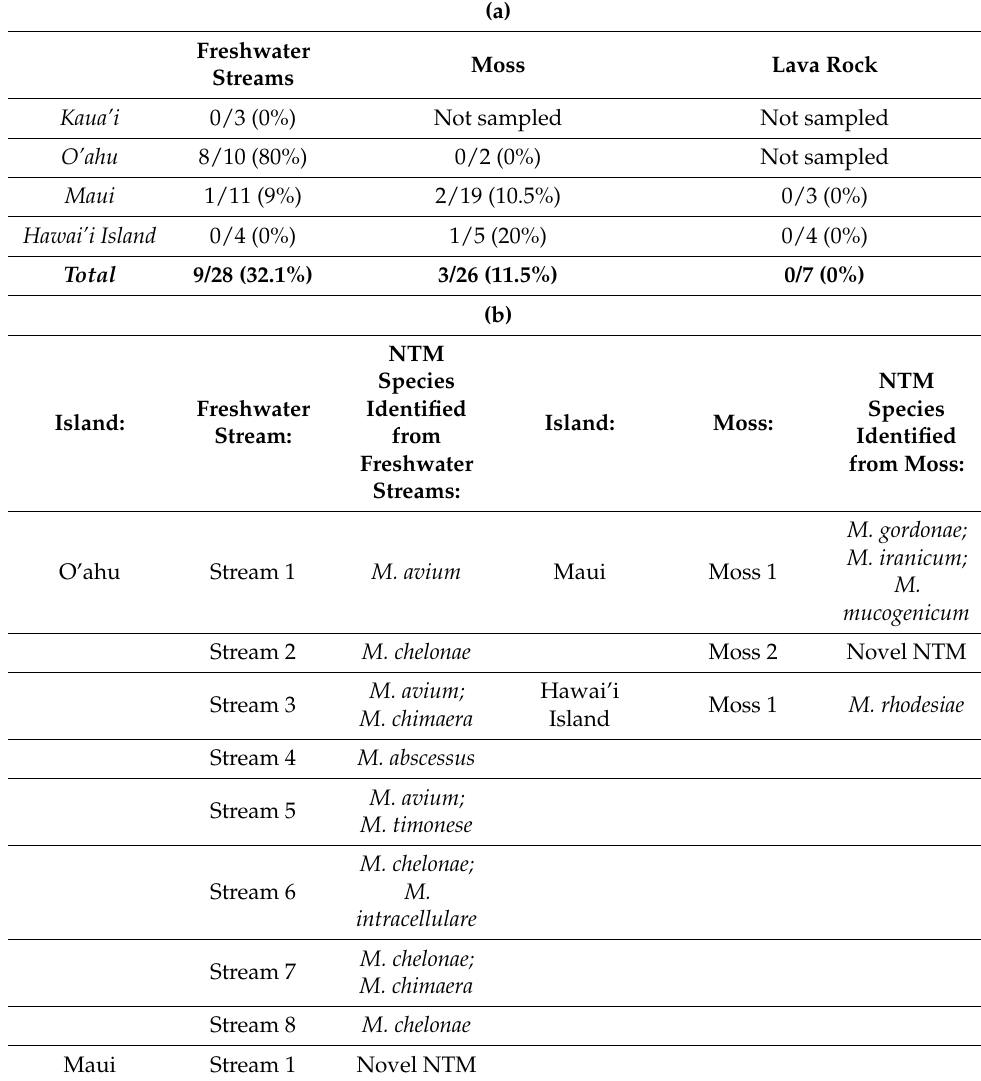
Table 5. ( a ) Types of natural sites sampled and the proportion that were NTM culture positive; ( b ) Species of NTM identified from culture positive freshwater streams and